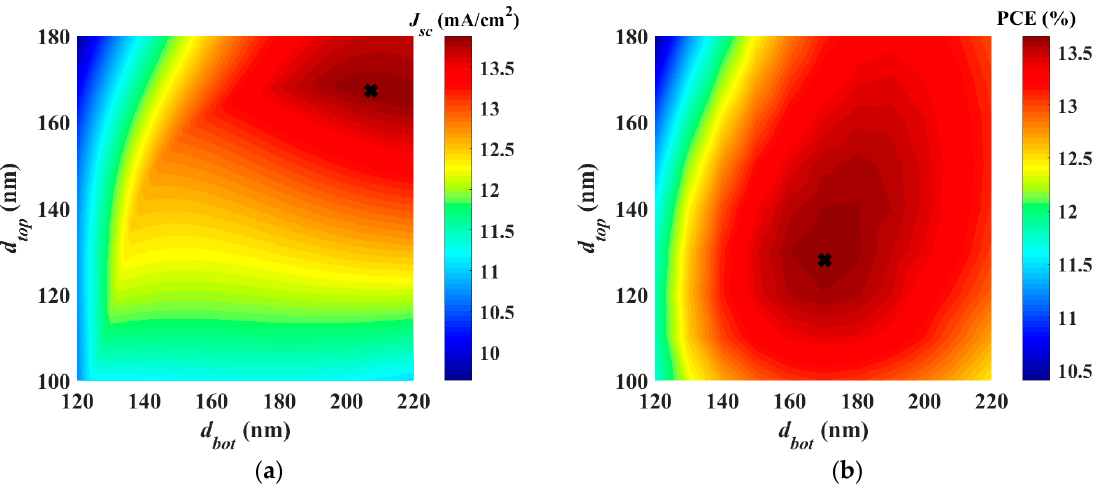
Figure 5. ( a ) Limiting photocurrent variation vs. the thickness of top ( t top ) and bottom ( t bot ) absorbers based on optical simulation. ( b ) Power conversion efficiency variation vs. the thickness of front and rear absorbers based on full coupled optoelectronic simulation. The black crosses point to the result of the direct global optimization.